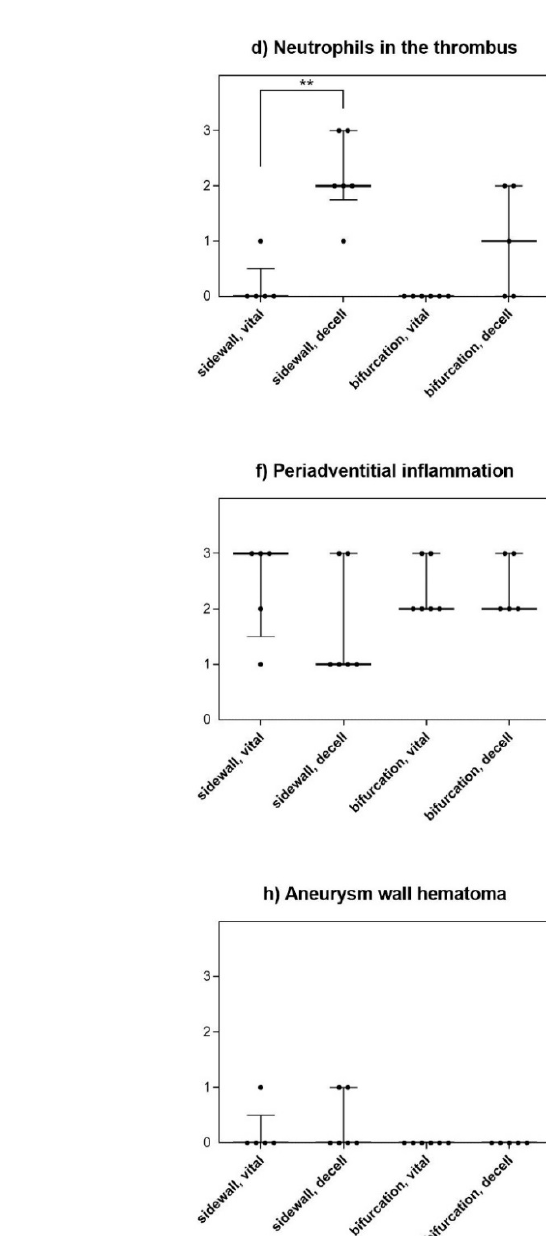
Figure 5. Detailed histological findings for all analyzed features. In both models, aneurysm wall cellularity was significantly lower in decellularized aneurysms than in vital aneurysms, confirming a successful experimental decellularization ( a ). Spontaneous thrombosis and neointima formation ( b ) were strong in the sidewall constellation, but not so in the bifurcation model. In the bifurcation model, aneurysm wall inflammation was significantly more pronounced in decellularized aneurysms when compared with vital aneurysms ( c ). However, there was no di ff erence in terms of aneurysm wall inflammation in the sidewall model. On the other hand, there were significantly more inflammation cells, i.e., neutrophils in the thrombus of decellularized sidewall aneurysms, a di ff erence not as distinctly observed in the bifurcation constellation ( d ). In turn, periadventitial fibrosis was significantly higher in vital than in decellularized bifurcation aneurysms, but not in sidewall aneurysms ( e ). There were no relevant di ff erences for periadventitial inflammation ( f ), aneurysm wall dissection ( g ) or aneurysm wall hematoma ( h ) between di ff erent wall conditions for either aneurysm model. A 4-scale grading system 0 = none, 1 = mild, 2 = moderate, 3 = severe was applied to characterize histology [11]. *: p < 0.05, ** p <